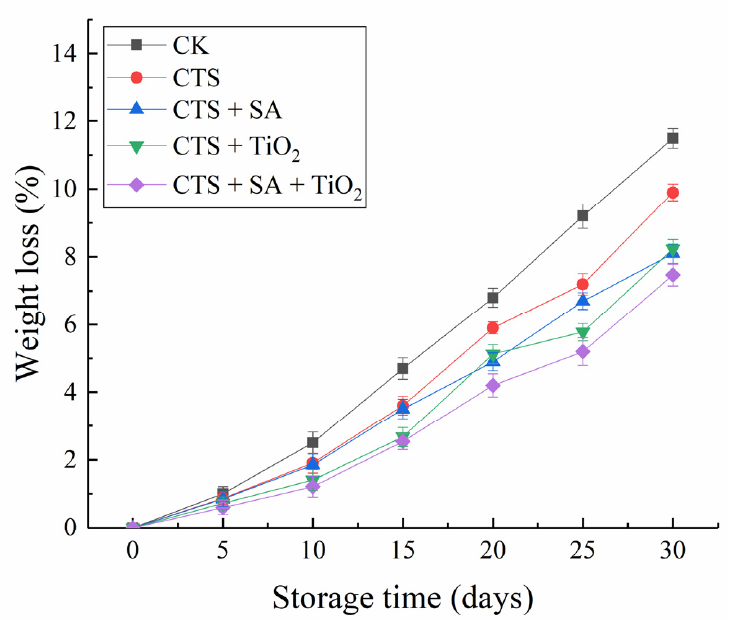
Figure 1. Effect of chitosan and chitosan composite coatings on weight loss (%) of blackcurrant fruit during storage.